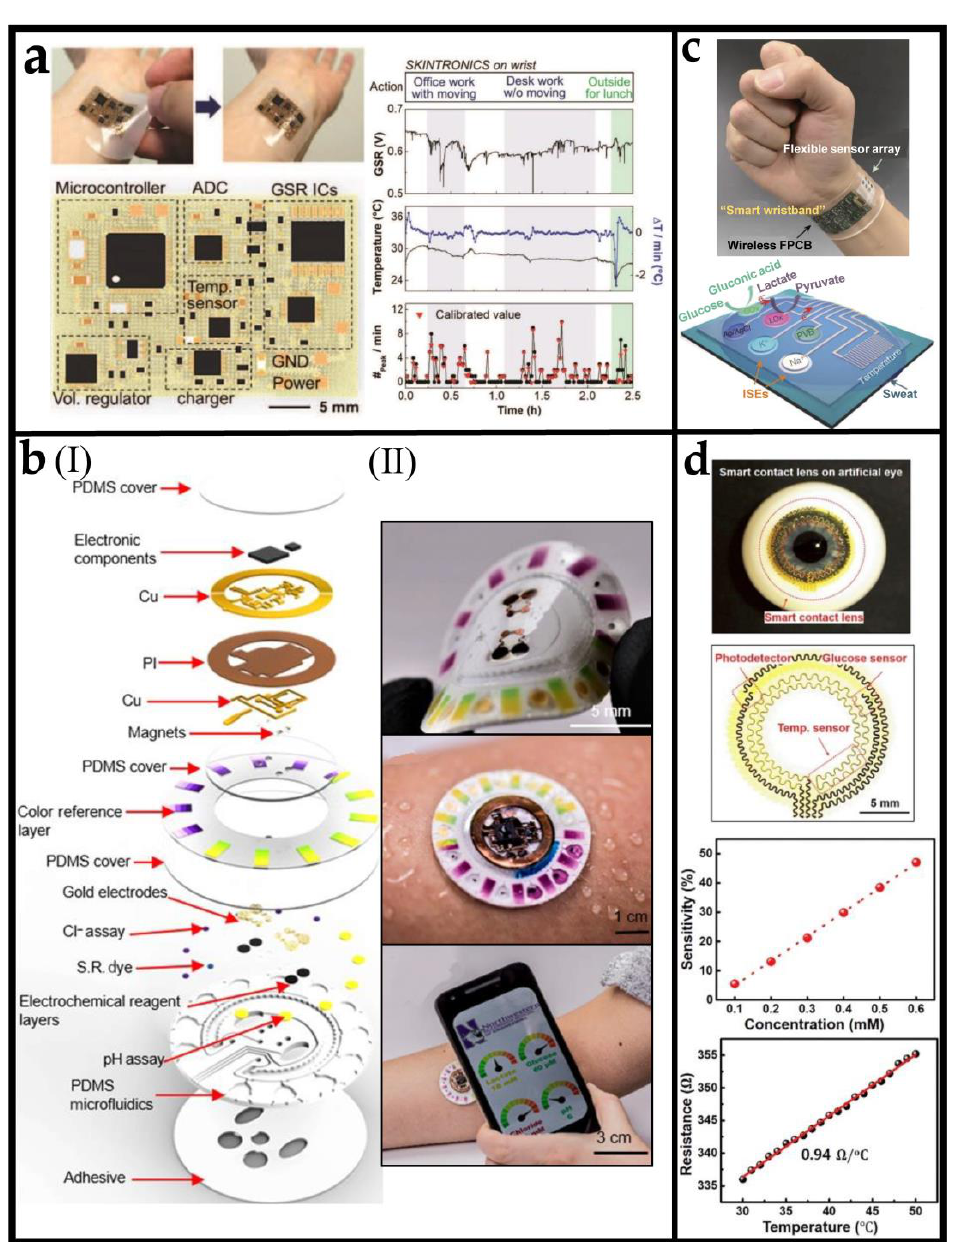
Figure 3. Planar integrated multifunctional sensors: ( a ) The stretchable circuit and real time monitoring results of kin-like bioelectronics (SKINTRONICS) for stress monitoring. Reprinted with permission from [92]. Copyright 2020 Wiley − VCH. ( b ) ( I ) Schematic illustrating the exploded view of the complete hybrid battery-free system. PI, polyimide; S.R., sweat rate. ( II ) Image illustrating the device and a phone interface that illustrates wireless communication and image acquisition. Reprinted with permission from [96]. ( c ) Images and schematic illustrations of the FISA for multiplexed perspiration analysis. Reprinted with permission from [97]. Copyright 2016 Nature Publishing Group. ( d ) The glucose sensor’s structural design, sensitivity (|DR|/R0) and temperature-dependent resistance curve. Reprinted with permission from [98]. Copyright 2021 Elsevier